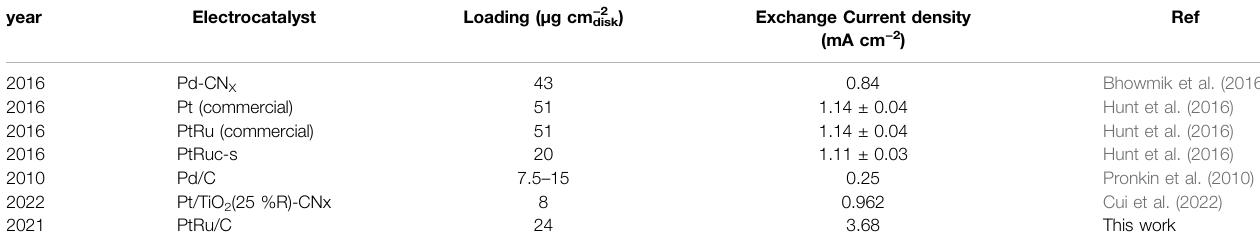
TABLE 2 | Comparison of the performance of HOR in acid